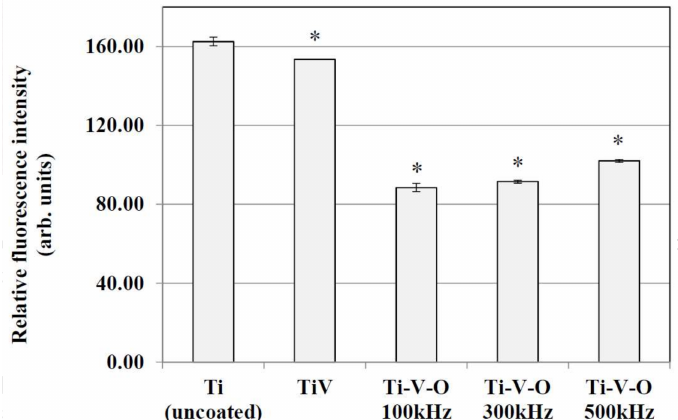
Figure 11. Antibacterial effects of the Ti (uncoated) sample, TiV coating, and LTSO Ti-V-O coating. * Significantly different from the control group—uncoated Ti plate ( p <